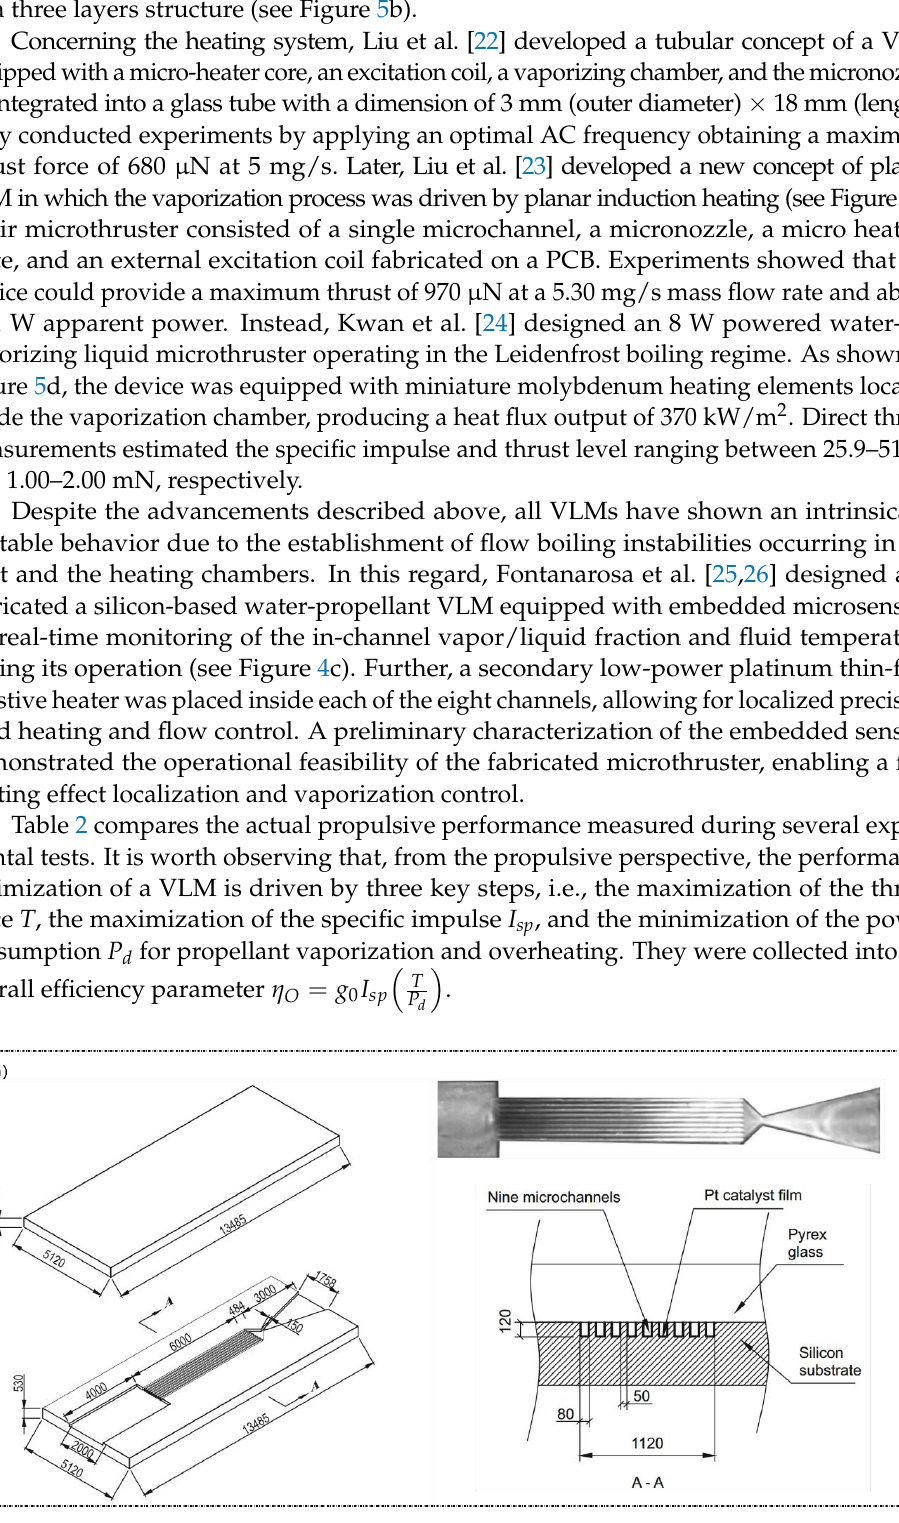
Figure 4. Manufactured VLMs in parallel microchannels configuration: ( a ) Cen and Xu [17]; ( b ) Silva et al. [18]; ( c ) Fontanarosa et al. [25].